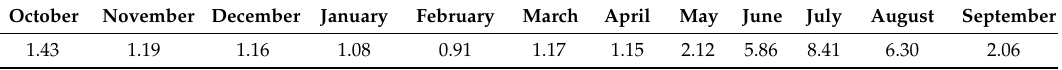
Table 1. Mean monthly water demand (hm 3 ).